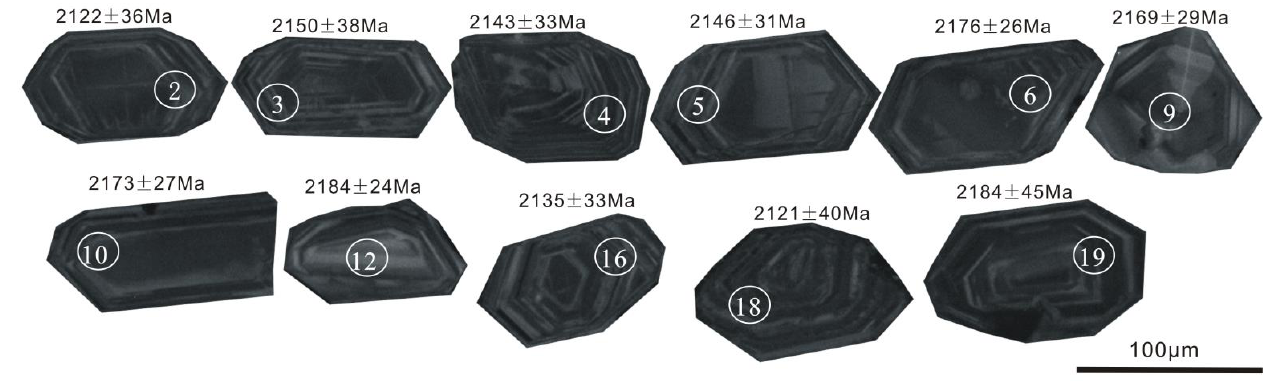
Figure 7. Zircon cathodoluminescence (CL) images of Tongkuangyu granodiorite porphyry. Table 2. LA–ICP–MS zircon U–Pb data of Tongkuangyu granodiorite porphyry.